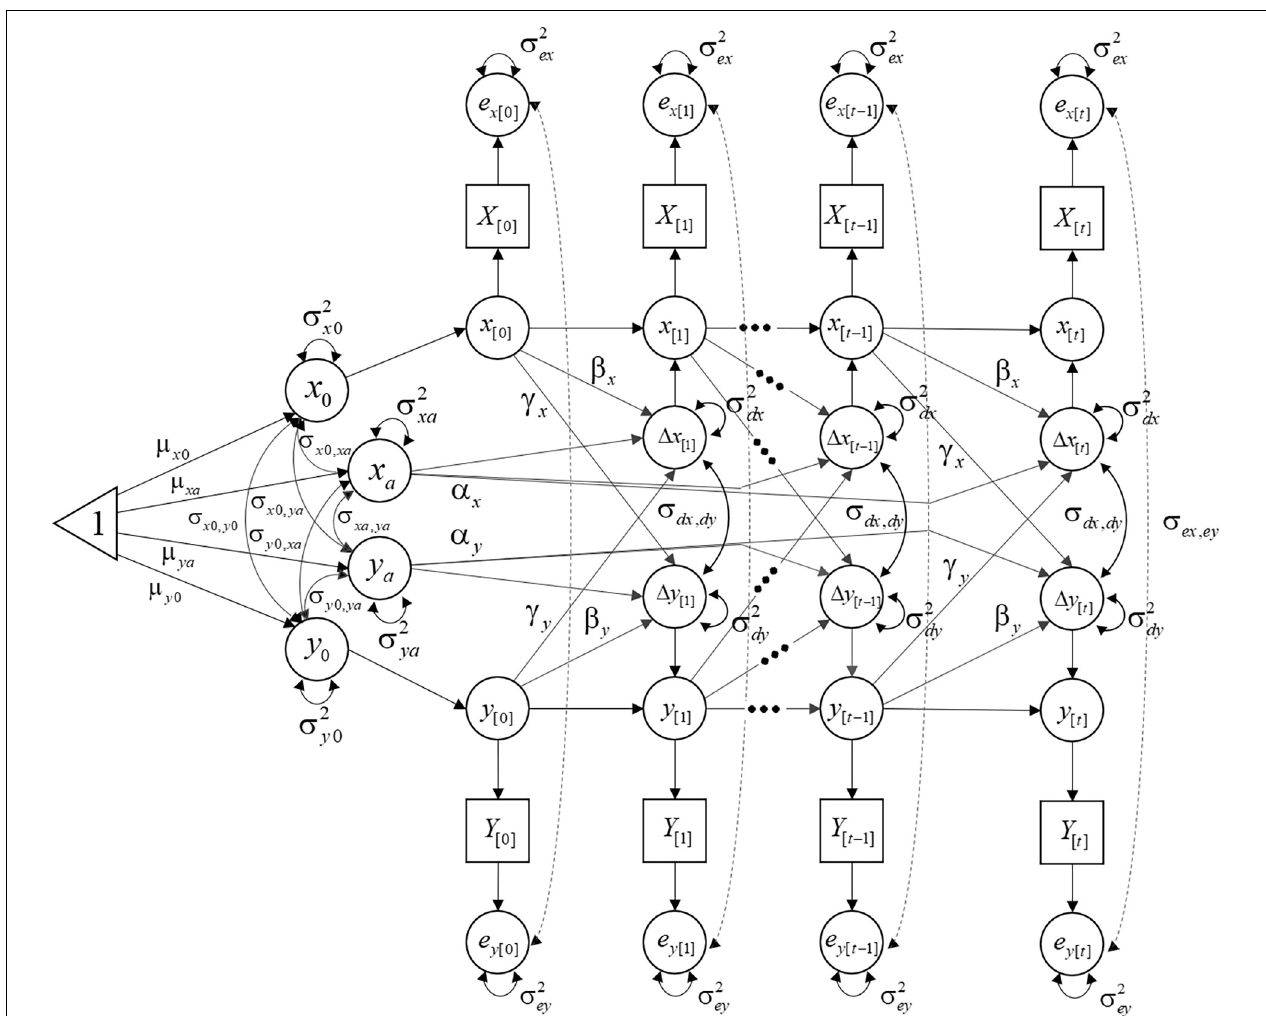
FIGURE 7 | Path diagram of a stochastic BLCS